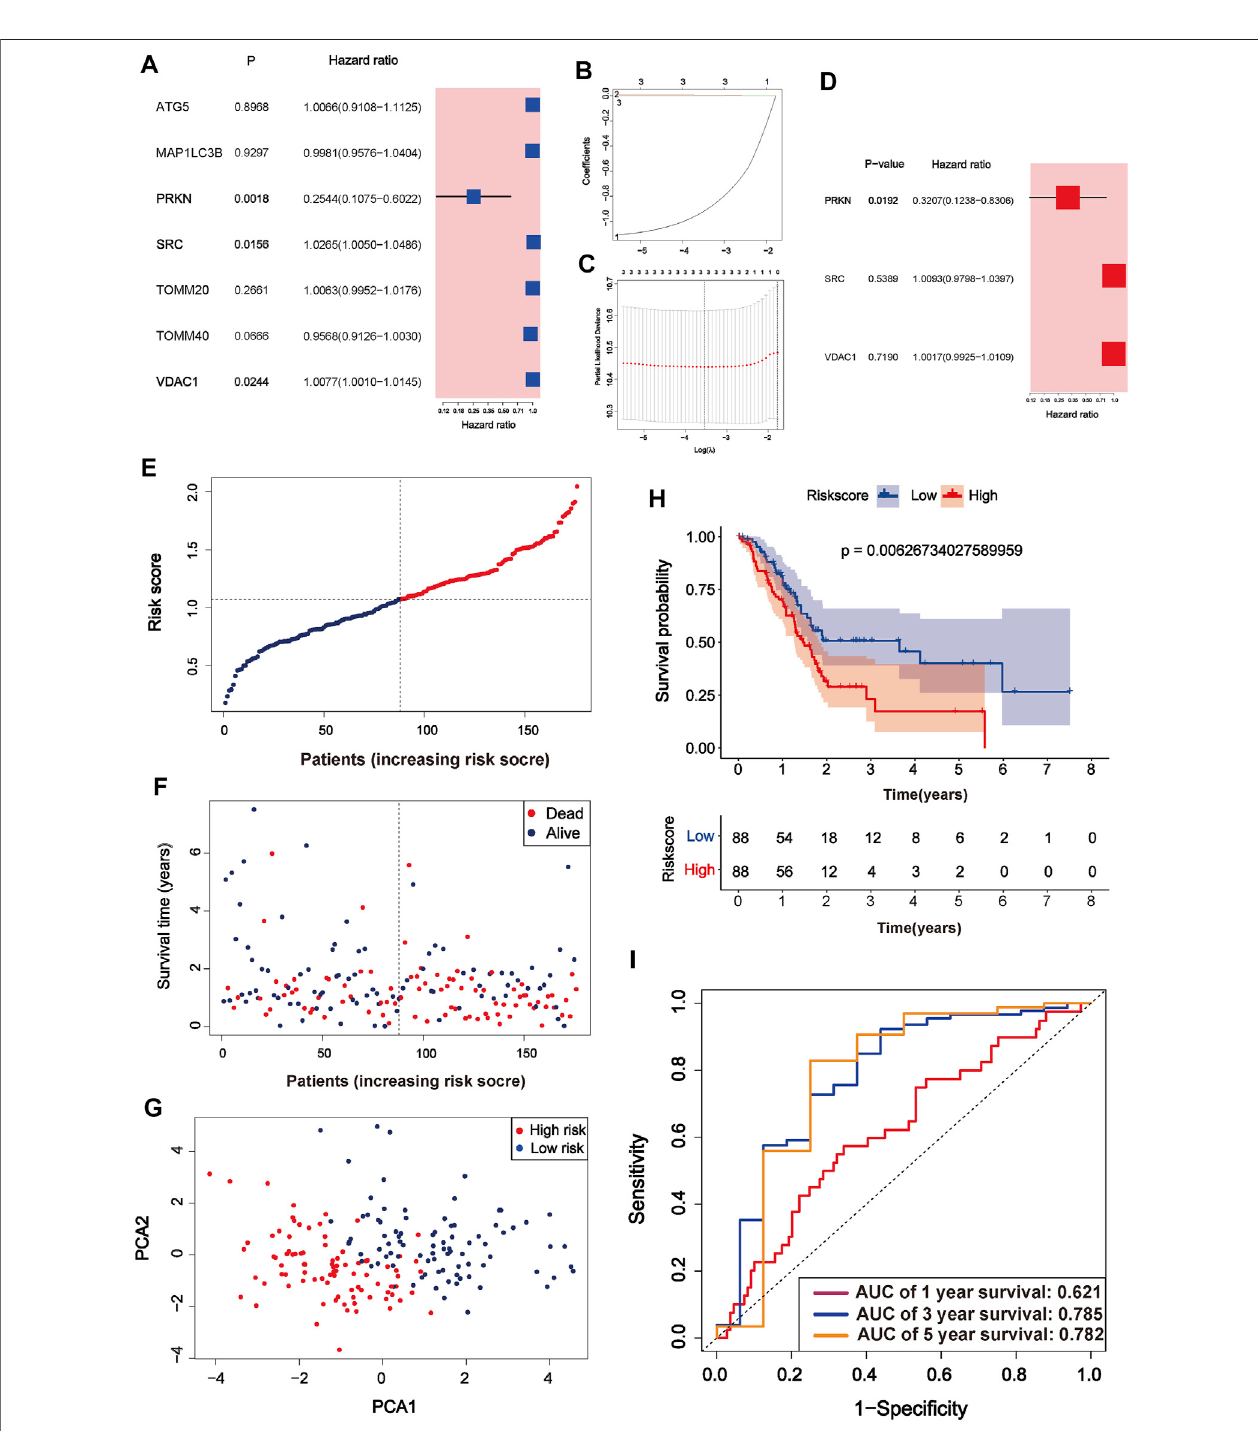
FIGURE 3 | Identi fi cation of mitophagy-related gene signature in TCGA cohort (A) A forest plot of prognosis-related genes after univariate Cox regression analysis (B) Theprocess ofleastabsoluteshrinkageand selectionoperator (LASSO) variablesscreening (C) Cross-validationofcandidategenesbasedontheminimumlambda value (D) A forest plot of independent prognosis-related genes using multivariate Cox regression analysis (E) Distribution of risk score for each PC sample in the TCGA cohort (F) Survival time and status ofeach PCsample based on the riskscore (G) Principal component analysis(PCA) ofthe 3-gene signature (H) Survival analysis between the two risk subgroups (I) ROC curve of the 3-gene signature.